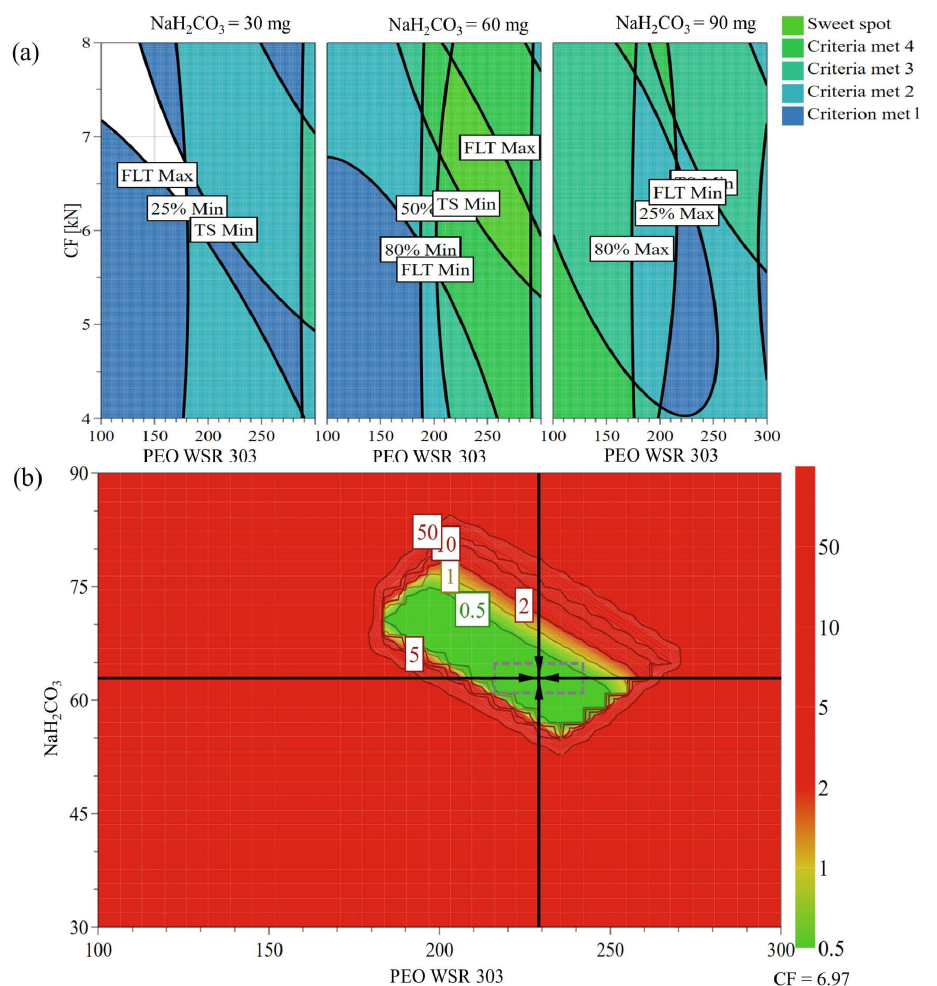
Figure 9. ( a ) Sweet spot plots of PEO amount ( x 1 ) and sodium bicarbonate ( x 2 ) at low ( left ), medium ( middle ), and high ( right ), and compression force (x 3 ), defined in the specification of time required for release: 25% (50 ≤ Y 1 ≤ 80 min; target, 60 min); 50% (220 ≤ Y 2 ≤ 260 min; target, 240 min); and 80% (510 ≤ Y 3 ≤ 570 min; target, 540 min). FLT (1 ≤ Y 4 ≤ 60 s; target, 30 s), and tensile strength (TS) (350 ≤ Y 6 ≤ 670 N/cm 2 ; target, 500 N/cm 2 ). ( b ) Design space in terms of PEO amount ( x 1 ) and sodium bicarbonate ( x 2 ) at low ( left ), medium ( middle ), and high ( right ), and compression force (x 3 ), defined in the specification of time required for release after the Monte Carlo